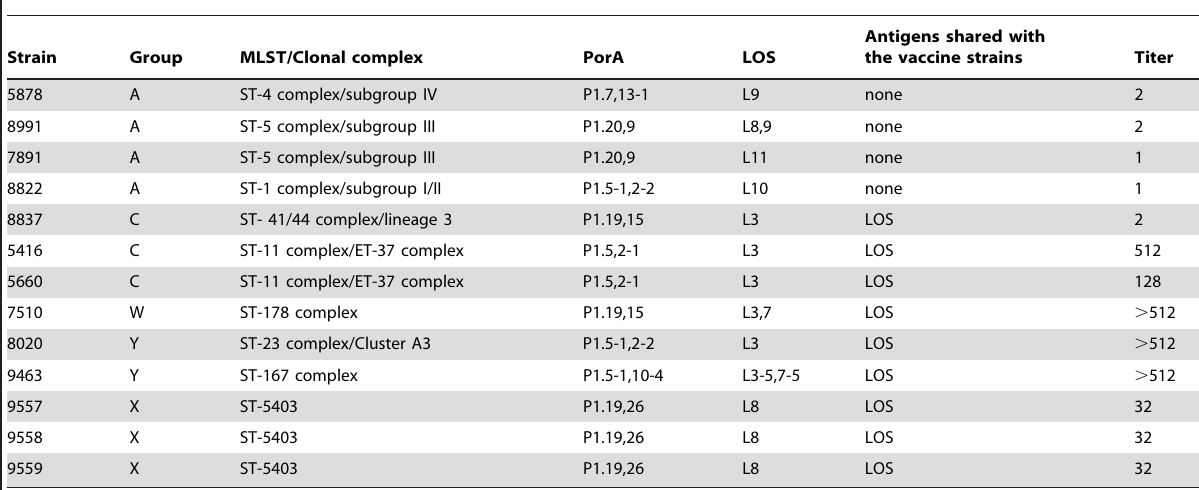
Table 2. Bactericidal activity against non serogroup B N. meningitidis strains.